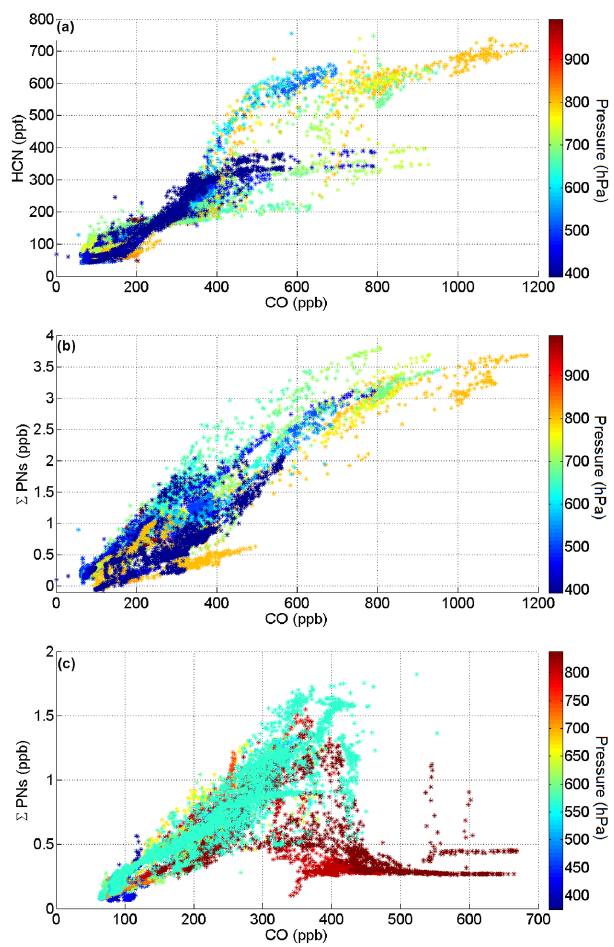
Figure 8. Simulation results for case A (only O 3 , CO, NO and CH 3 CN as inputs): scatter plots of simulated HCN and measured CO for flight B622 (a) ; simulated P PNs and measured CO (b) for B622; simulated P PNs and measured CO for B623 (c)